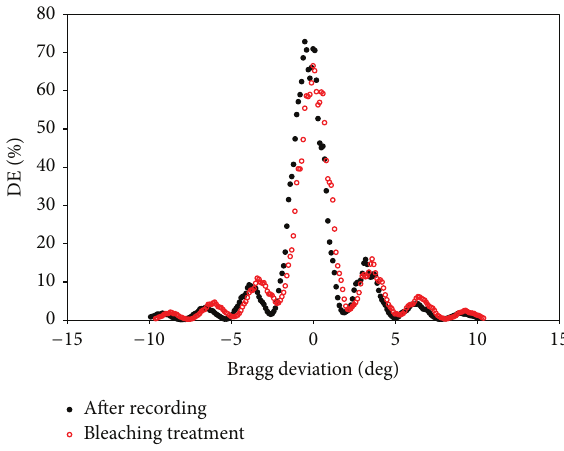
Figure 2: A fresh composite solution, B one day aged solution, C heated solution, and D solution activation process. Figure 3: Angular scan after recording and after